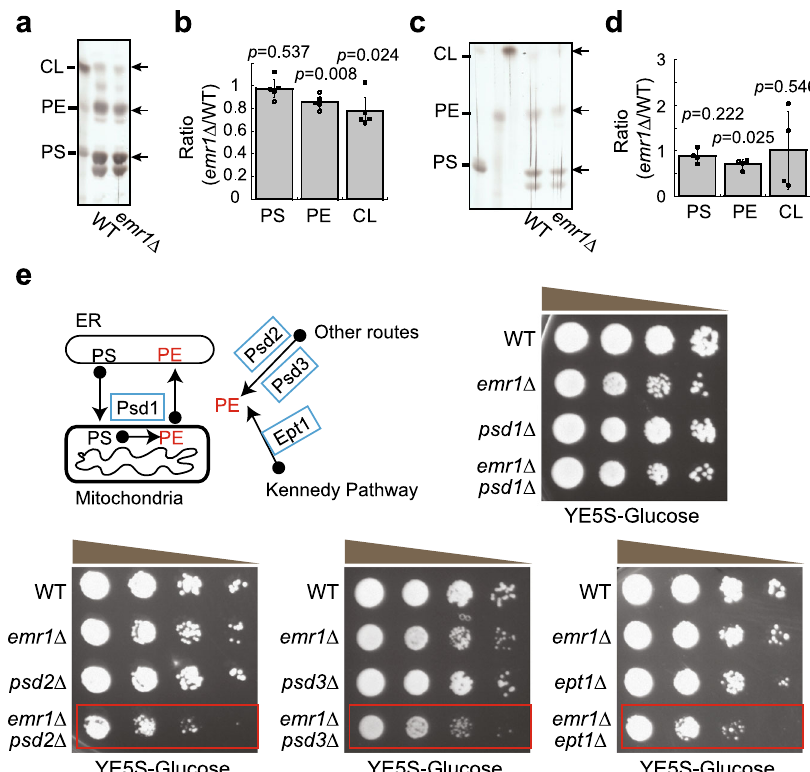
Fig. 8 The absence of Emr1 affects the synthesis of phosphatidylethanolamine. a Thin-layer chromatography (TLC) assays. TLC analysis of phospholipids extracted from WT and emr1 Δ cells (whole-cell lysates). Phosphatidylserine (PS), phosphatidylethanolamine (PE), and cardiolipin (CL) were used as lipid standards (indicated by arrows). b Quanti fi cation of CL, PE, and PS shown in a . The band intensity of emr1 Δ cells was normalized to the one of WT cells (displayed as Ratio). Data from fi ve independent experiments were used for the quanti fi cation (indicated by dots). Error bars represent con fi dence intervals (95%), and the center of the error bar is the mean. Two-sided single-group Student ’ s t -test was used to calculate the p -values of log ratio for each type of phospholipids (PS, p = 0.537; PE, p = 0.008; CL, p = 0.024). c TLC analysis of phospholipids extracted from isolated mitochondria of WT and emr1 Δ cells. Arrows indicate lipid standards. d Quanti fi cation of CL, PE, and PS shown in c . The band intensity of emr1 Δ cells was normalized to the one of WT cells (displayed as Ratio). Data from four independent experiments were used for the quanti fi cation (indicated by dots). Error bars represent con fi dence intervals (95%), and the center of the error bar is the mean. Two-sided Single-group Student ’ s t -test was used to calculate the p -values of log ratio for each type of phospholipids (PS, p = 0.222; PE, p = 0.025; CL, p = 0.546). e Growth assays for the indicated cells. The indicated cells were spotted on YE5S plates containing glucose after tenfold serial dilution. Diagram showing the routes of PE synthesis. (1) The PS decarboxylase Psd1 resides in mitochondria to convert PS to PE after PS is transferred from the ER to mitochondria through the contact sites between the ER and mitochondria; (2) the PS decarboxylases Psd2 and Psd3 likely resides in other cellular compartments (except mitochondria) to synthesize PE; (3) Ept1 in the Kennedy pathway promotes the synthesis of PE. Note that psd2 Δ , psd3 Δ , and ept1 Δ , but not psd1 Δ , had an additive growth defect with emr1 Δ (highlighted by red